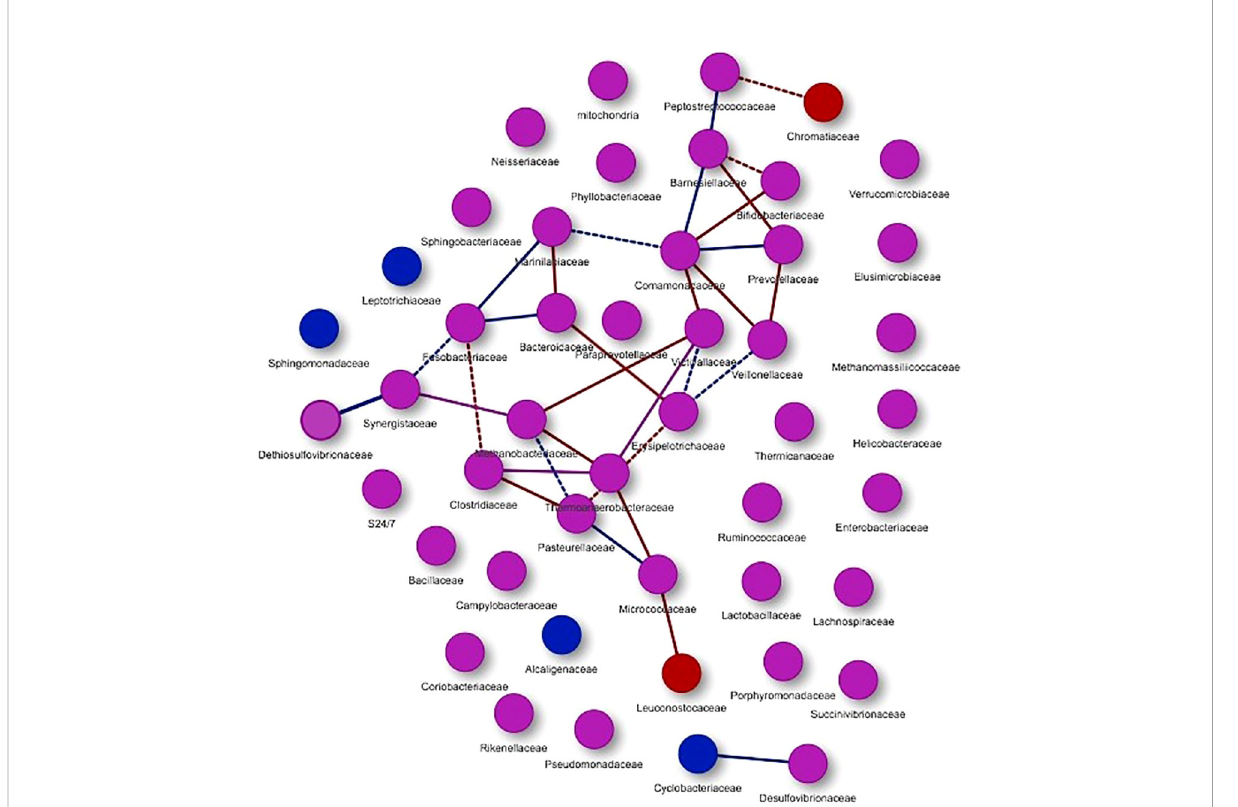
FIGURE 5 Co-occurrence networks of microorganisms present in the study groups. Purple nodes represent the presence of microorganisms in both groups, while red nodes are mainly associated with hypercholesterolemic individuals and blue nodes with controls. With the same colors the interactions or edges are evidenced, associating these to the study groups. Continuous lines (edges) refer to co-occurrences that occur between microorganisms with a higher frequency than expected, while dashed lines correspond to interactions with less frequency than expected. P-value